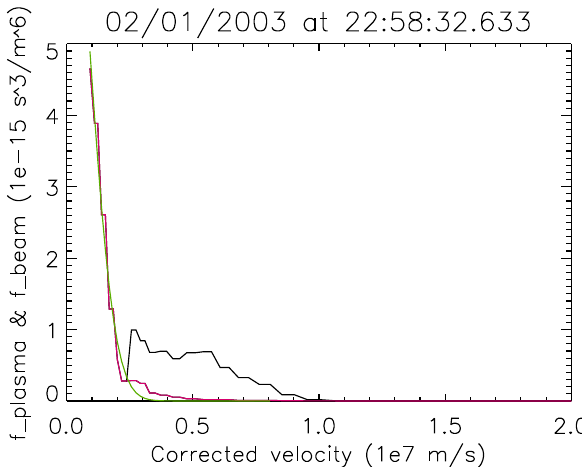
Fig. 9. Distribution functions of the beam f //b (black) and the am- bient plasma f p (red) observed by PEACE on the 2 January 2003 at 22:58:32.633 UT with a Maxwellian fit of the plasma contribution